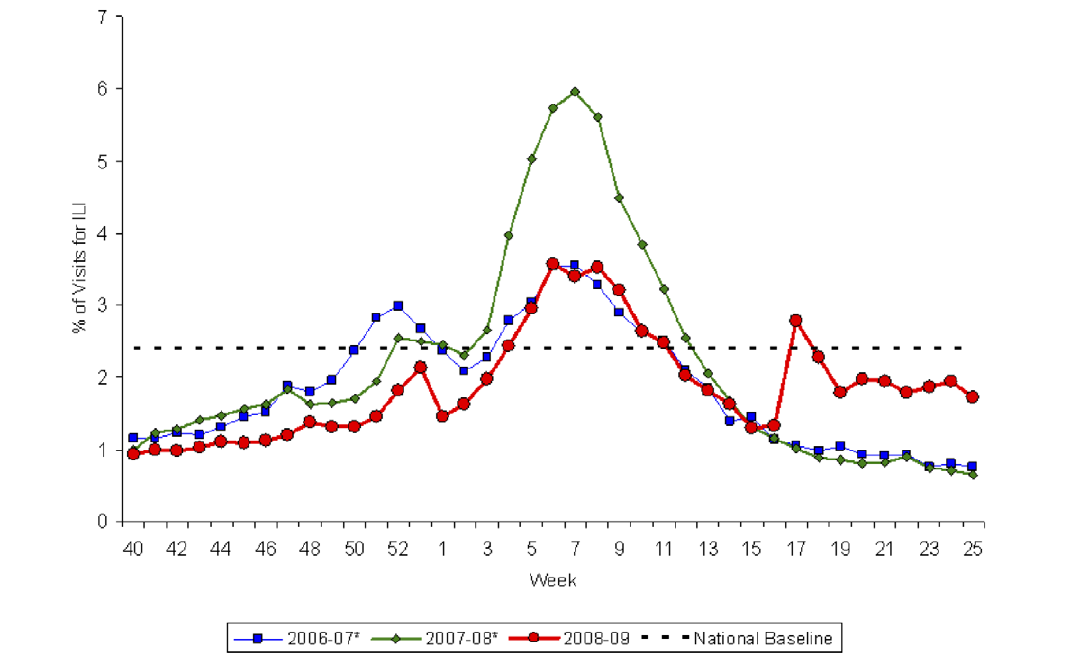
Figure 4. Outpatient influenza-like illness surveillance. Percentage of visits for ILI Reported by the U.S. Outpatient Influenza-like Illness Surveillance Network (ILINet), National Summary 2008–09 and Previous Two Seasons. Source: CDC Flu View, 2008–2009 Influenza Season Week 25 ending June 27, 2009. Available from: http://www.cdc.gov/flu/weekly/weeklyarchives2008-2009/weekly25.htm.